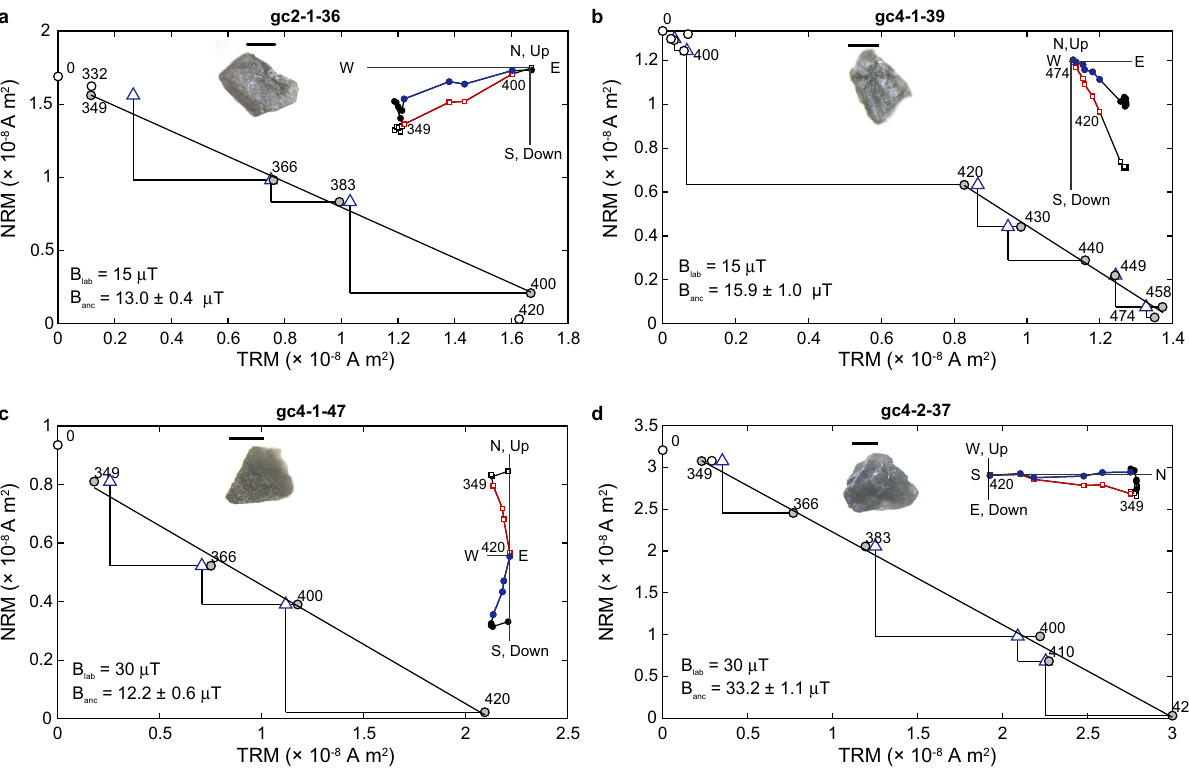
Fig. 2 Thellier – Coe paleointensity experiments of single plagioclase crystals from the Glen Mountains Layered Ma fi c Complex anorthosites. a – d Natural remanent magnetization (NRM) lost versus thermal remanent magnetization (TRM) gained (circles) and partial thermal remanent magnetization checks (triangles). All labeled points are o C. Gray circles are steps used in fi t (applied fi eld B lab and paleointensity value B anc shown in lower left). Insets: crystal measured shown in the top center with 1mm scale bar. An orthogonal vector plot of fi eld-off steps is shown in the upper right. Squares are the vertical projection of the magnetization; circles are the horizontal projection. Temperature ranges used in the paleointensity fi t are labeled and symbols are in